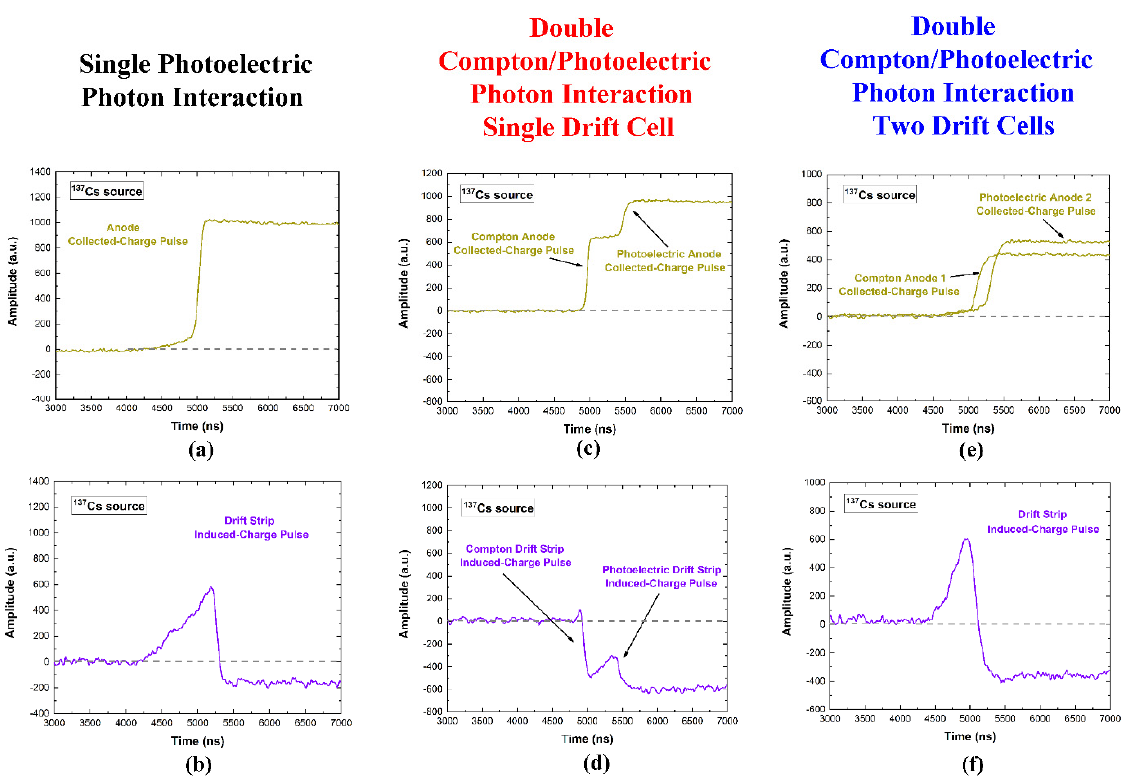
Figure 3. Examples of single and double interaction pulses from the collecting anodes and the related drift strips, measured in temporal coincidence. ( a ) Single photoelectric collected-charge pulse from a collecting anode and ( b ) the related induced-charge pulse from the drift strip. ( c ) Compton and photoelectric collected-charge pulses from one collecting anode and ( d ) the related induced-charge pulses from the drift strip; both pulses are detected within a single drift cell. ( e ) Compton and photoelectric collected-charge pulses from two collecting anodes and ( f ) the related induced-charge pulses from the drift strip; here, the pulses are detected by two different drift cells.